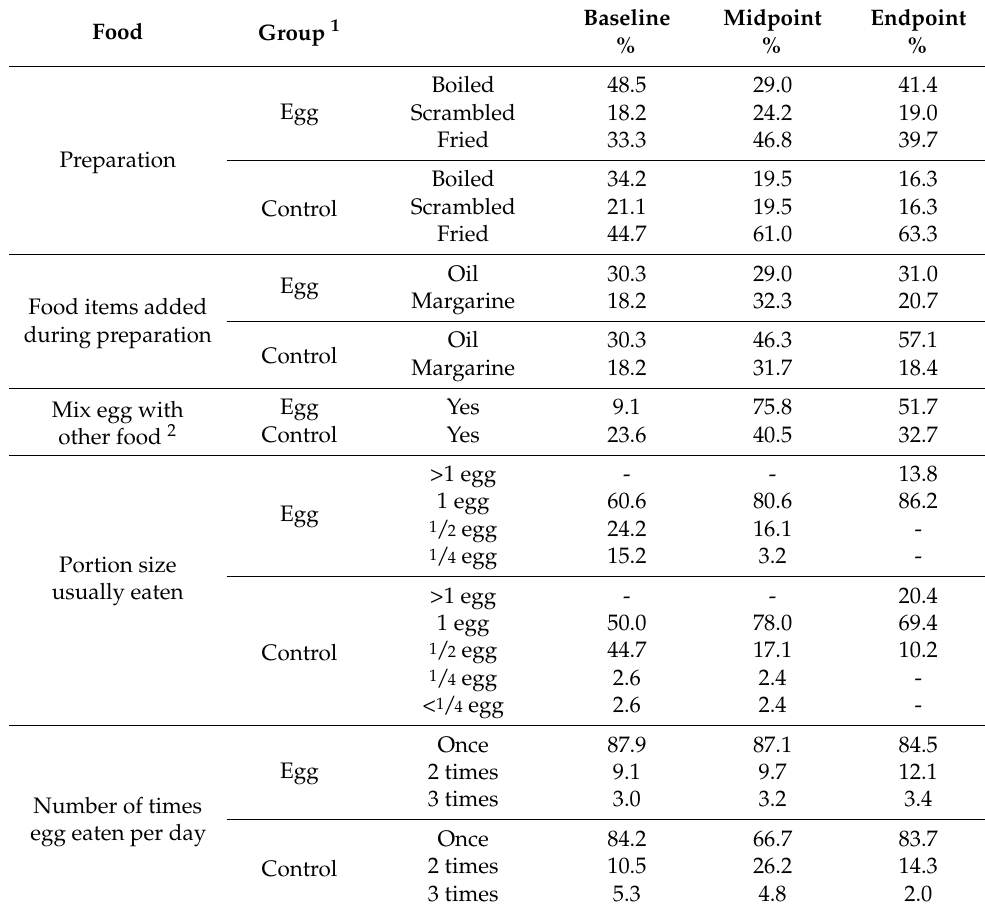
Table 7. Preparation of eggs and amount eaten, expressed as a percentage of babies who ate egg during the preceding